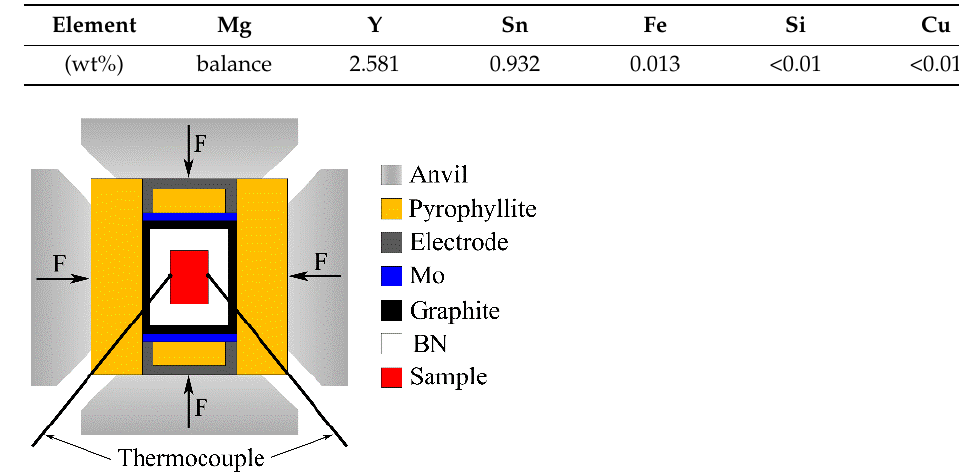
Table 1. The composition of the Mg-1Sn-2.5Y alloy.